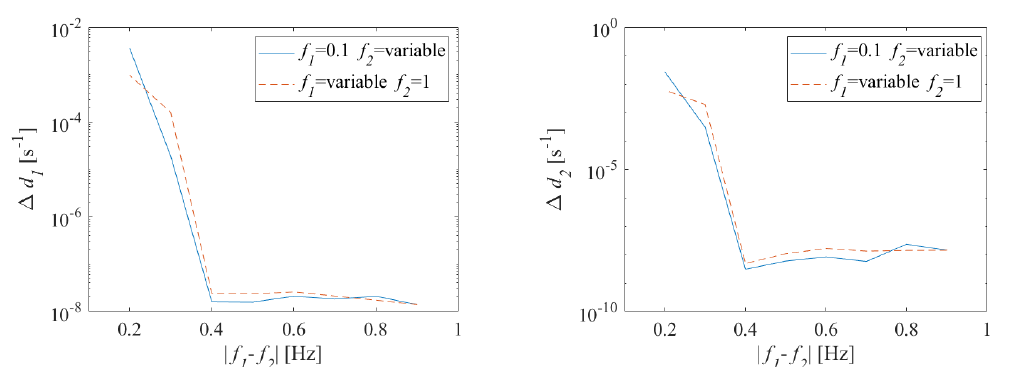
Figure 7. Figure of merit (FoM) evolution versus frequency distance between the components obtained in numerical tests with ideal signal; results for components with damping d 1 ( on the left ) and damping d 2 ( on the right